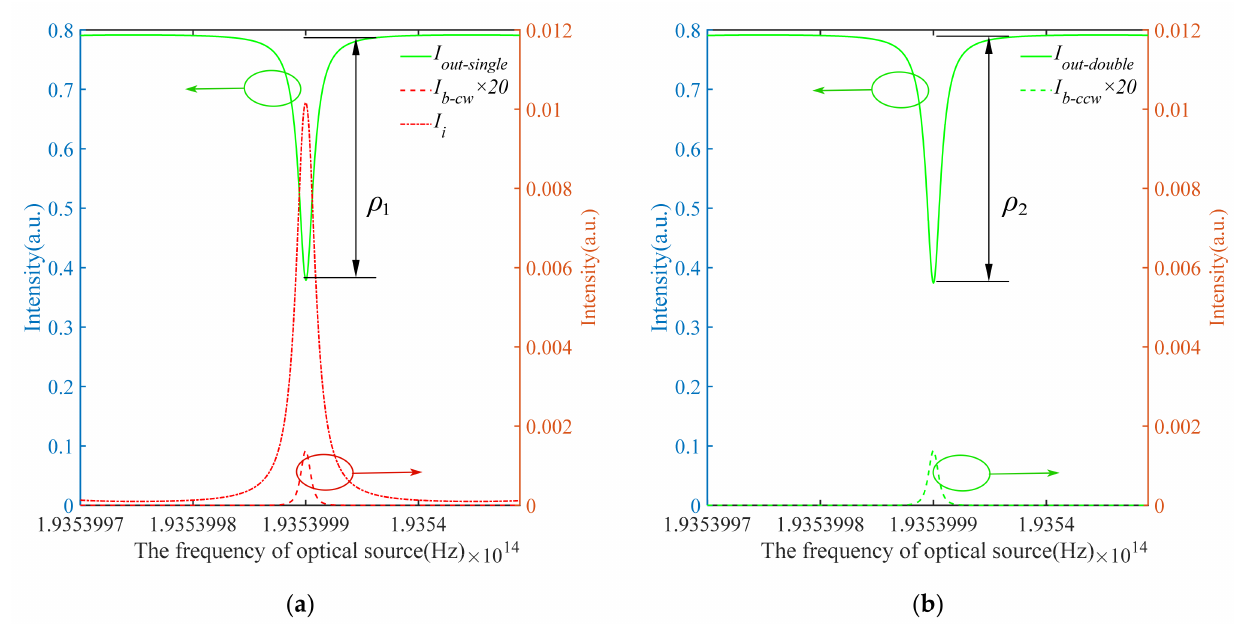
Figure 3. Simulated results of the Rayleigh backscattering noise in the CCW direction of the RFOG: with ( a ) a single HCPCF ring resonator; with ( b ) the parallel-double HCPCF ring resonator.